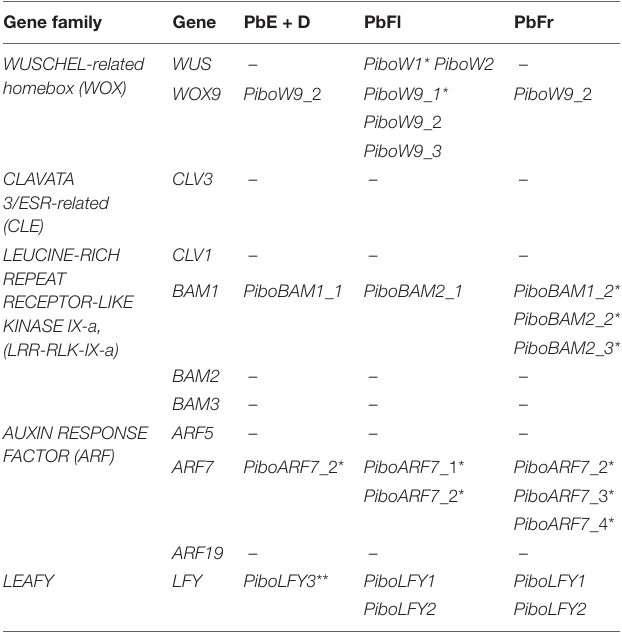
TABLE 2 | BLAST targeted genes in the three transcriptomes of P. boyacensis